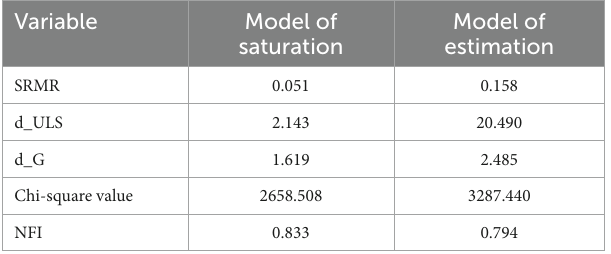
TABLE 6 Model matching degree.